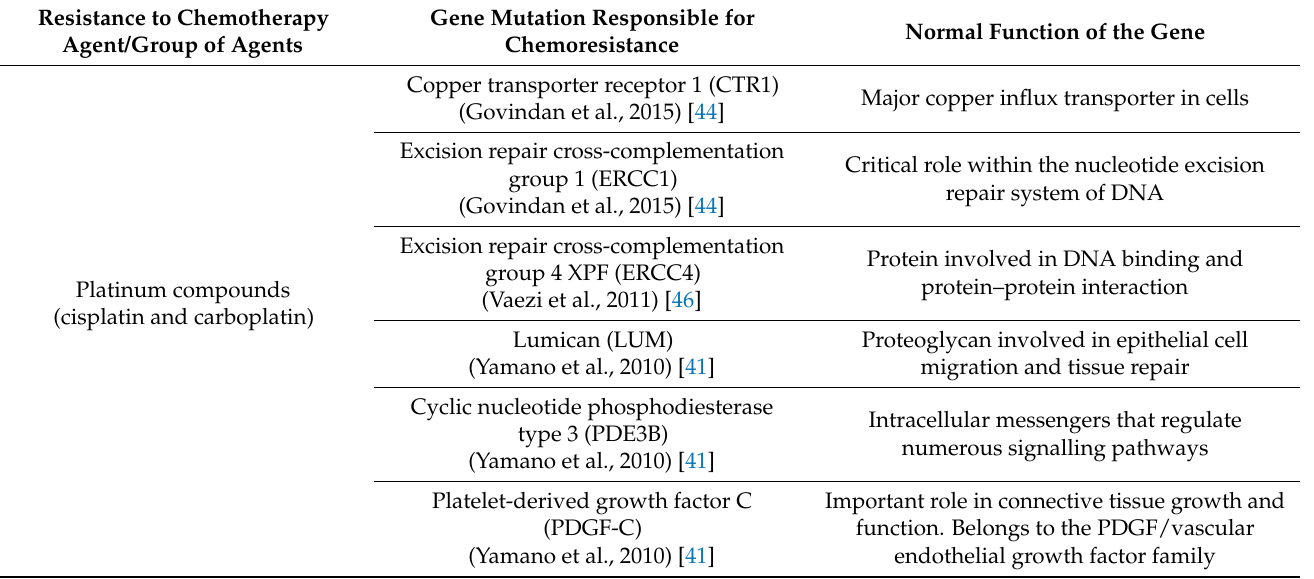
Table 2. Gene mutations in HNC responsible for chemotherapy resistance. Resistance to Chemotherapy Gene Mutation Responsible Agent/Group of Agents